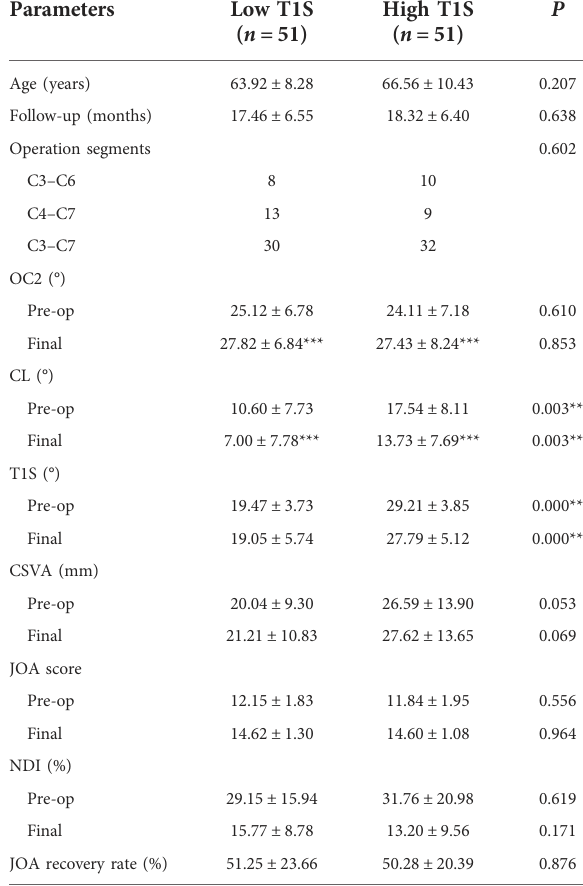
TABLE 2 Comparison of cervical sagittal parameters and HRQOL indicators between the low T1S group and the high T1S group.